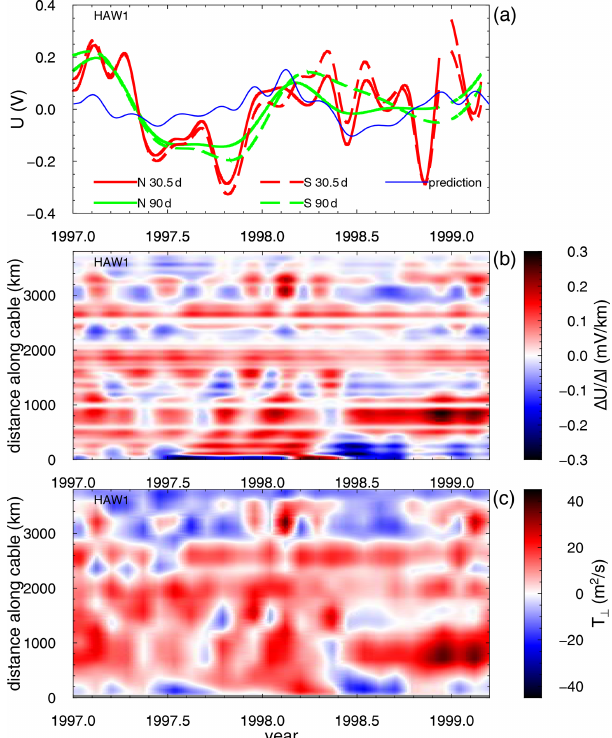
Figure 4. The results for the OKI cable. (a) The smoothed time se- ries of cable voltages using 30.5 and 90d knot separation are shown in red and green, respectively. The blue line corresponds to the pre- dictions obtained by the numerical model. (b) The time develop- ment of the voltage gradient along the cable length from the 3-D model. In panel (c) , we plot the ECCOv4r4 vertically integrated transport across the cable in a similar way. The cable orientation follows Table 1, from Honshu to Okinawa.